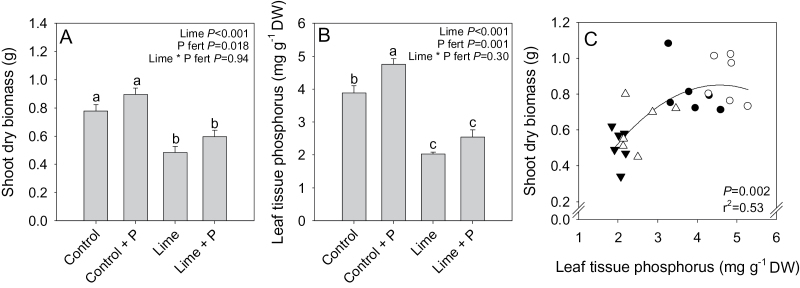
Shoot dry biomass (A) and leaf tissue phosphorus concentration (B) of control ●, control+P fertilizer ○-, lime ▼-, or lime+P fertilizer △-treated Pisum sativum, and relationship between shoot dry biomass and leaf tissue phosphorus concentration (C). Data are means ±SE of 8–10 (A) or six (B) replicates. Two-way ANOVA results (P-values reported) are indicated in (A) and (B), with different letters above bars indicating significant differences as determined by Tukey pair-wise analysis. Data points in (C) represent individual plants with a second-order polynomial regression line fitted, with P-values and r
2 shown.